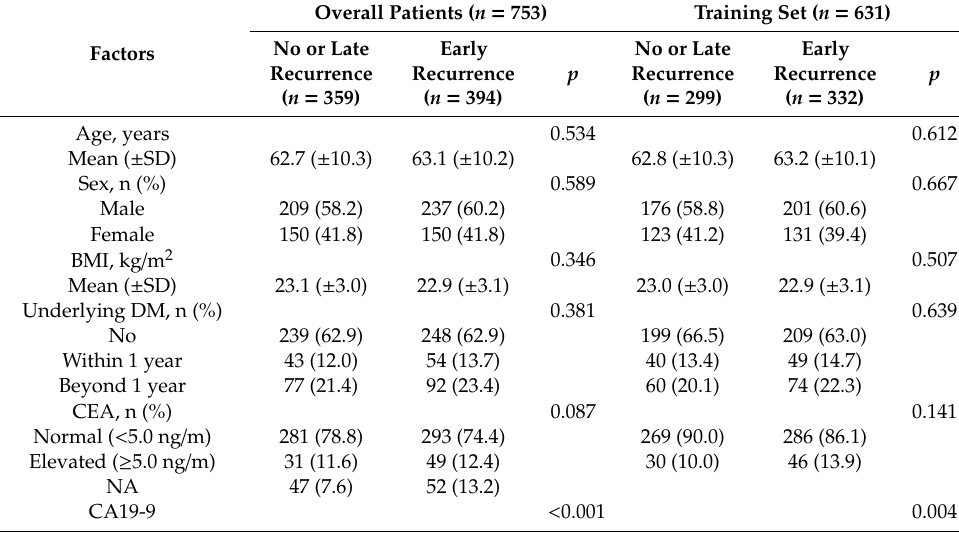
Table 1. Preoperative demographic features of the overall patients and the training